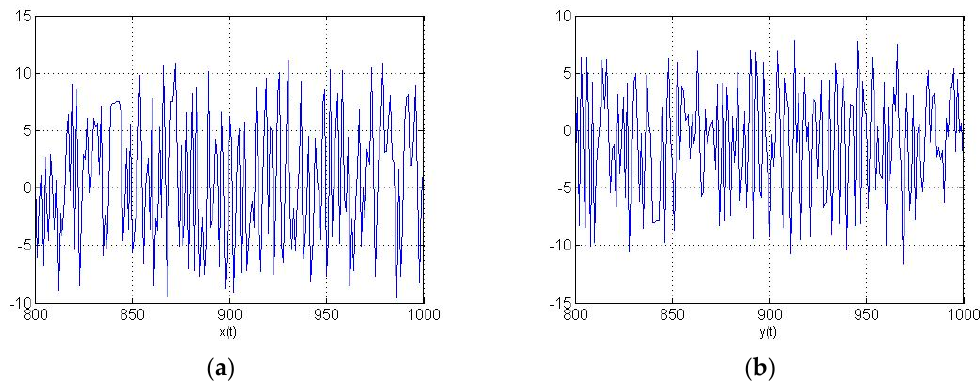
Figure 5. Encoded state variables at the transmitter: ( a ) state variable X(t) ; ( b ) state variable Y(t) .